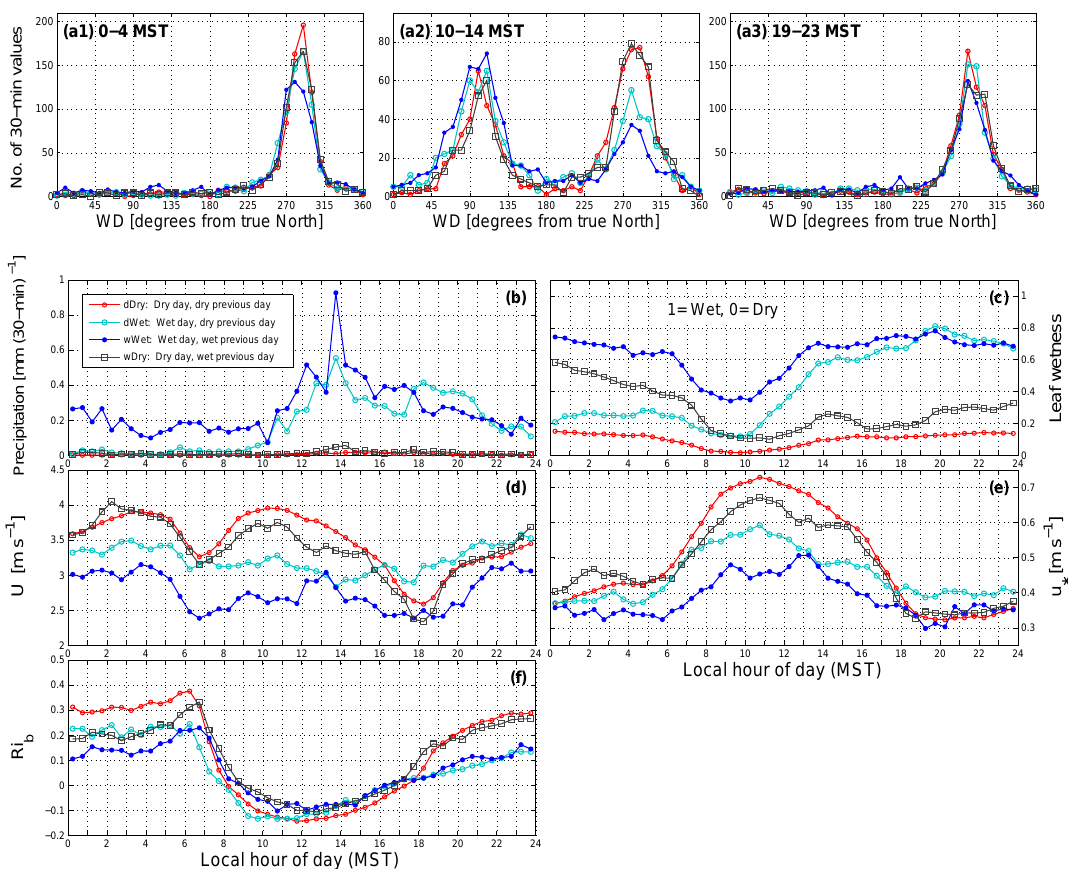
Figure 3. Frequency distributions of wind direction WD for different precipitation states for (a1) nighttime (00:00–04:00MST) (a2) mid-day (10:00–14:00MST), and (a3) late evening (19:00–23:00MST) periods. Because there are a different number of 30min periods within each precipitation state, the frequency distributions were created by randomly selecting 800 values for each precipitation state. Below (a1–a3) , the mean warm-season diel cycle of (b) precipitation, (c) leaf wetness, (d) 21.5m horizontal wind speed U , (e) 21.5m friction velocity u ∗ , and (f) bulk Richardson number Ri b are shown. These composites are from 30min data during the warm season between years 1999 and 2012. For all panels, each line represents a different precipitation state as shown in the legend of panel (b)